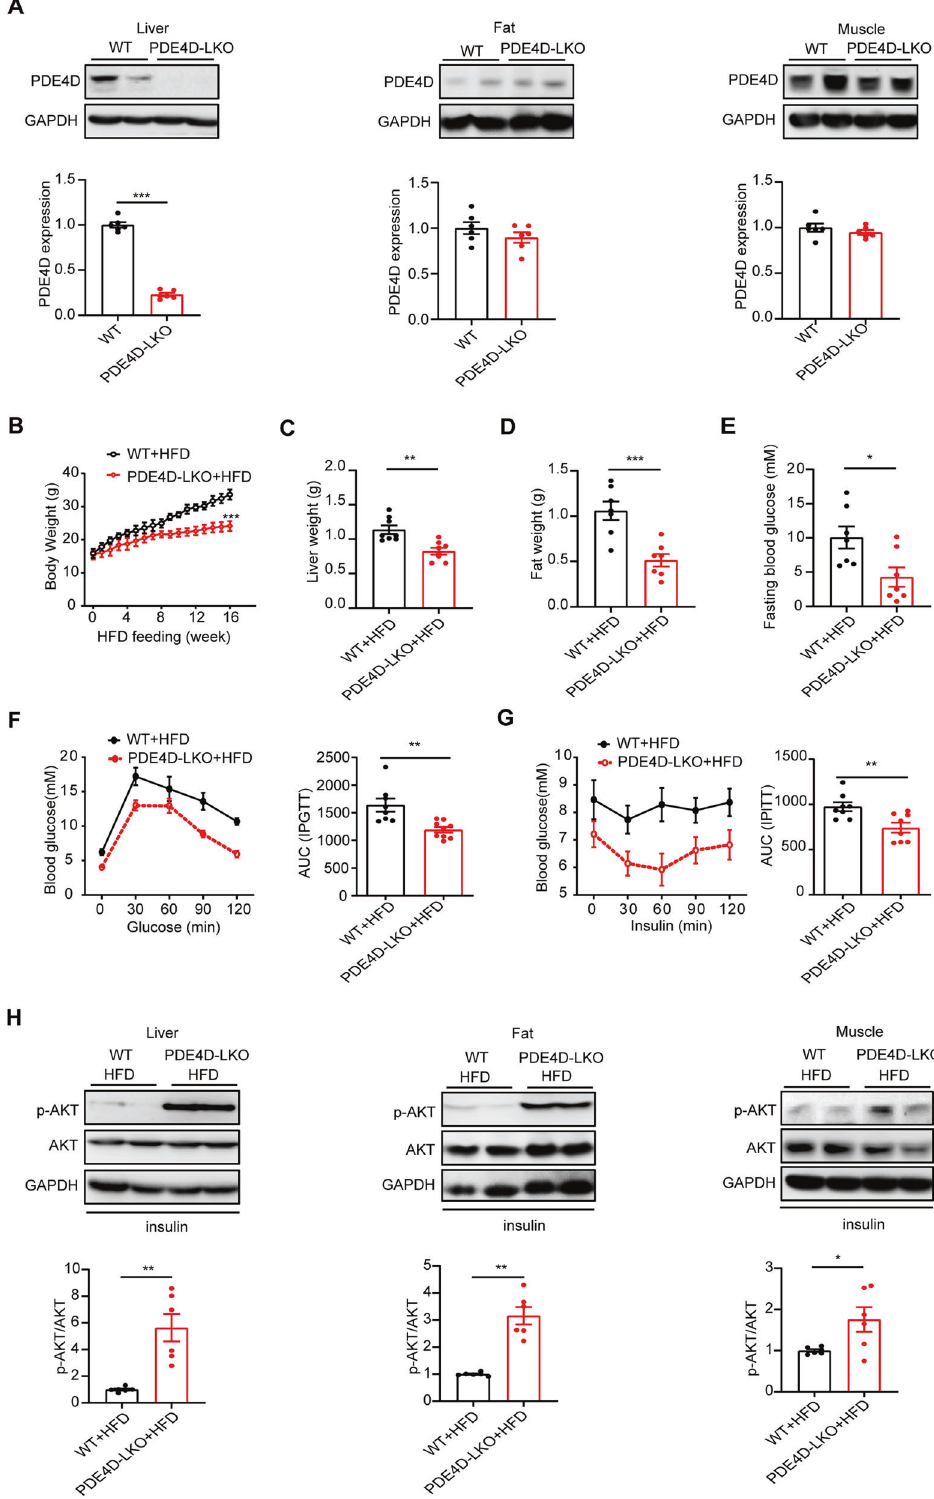
Fig. 2 Genetic deletion of hepatic PDE4D improved the metabolic abnormalities induced by HFD. A The protein levels of PDE4D in liver (left), epididymal fat (center), and gastrocnemius muscle (right) tissue of WT and PDE4D-LKO mice. B Body weight curves of WT and PDE4D- LKO mice during 16 weeks of HFD consumption. C Liver weight of the two groups of mice at week 16. D Epididymal fat weight of the two groups of mice at week 16. E Fasting blood glucose of the two groups of mice at week 16. F , G GTT ( F ) and ITT ( G ) were performed in the WT and PDE4D-LKO groups at week 16, and the AUCs of GTT and ITT were calculated. H Phosphorylation of AKT in liver (left), epididymal fat (center), and gastrocnemius muscle (right) after mice were injected with insulin for 15 min ( n = 6). Data are shown as the means ± SEMs. * P < 0.05, ** P < 0.01, *** P < 0.001 by two-tailed Student ’ s t test.